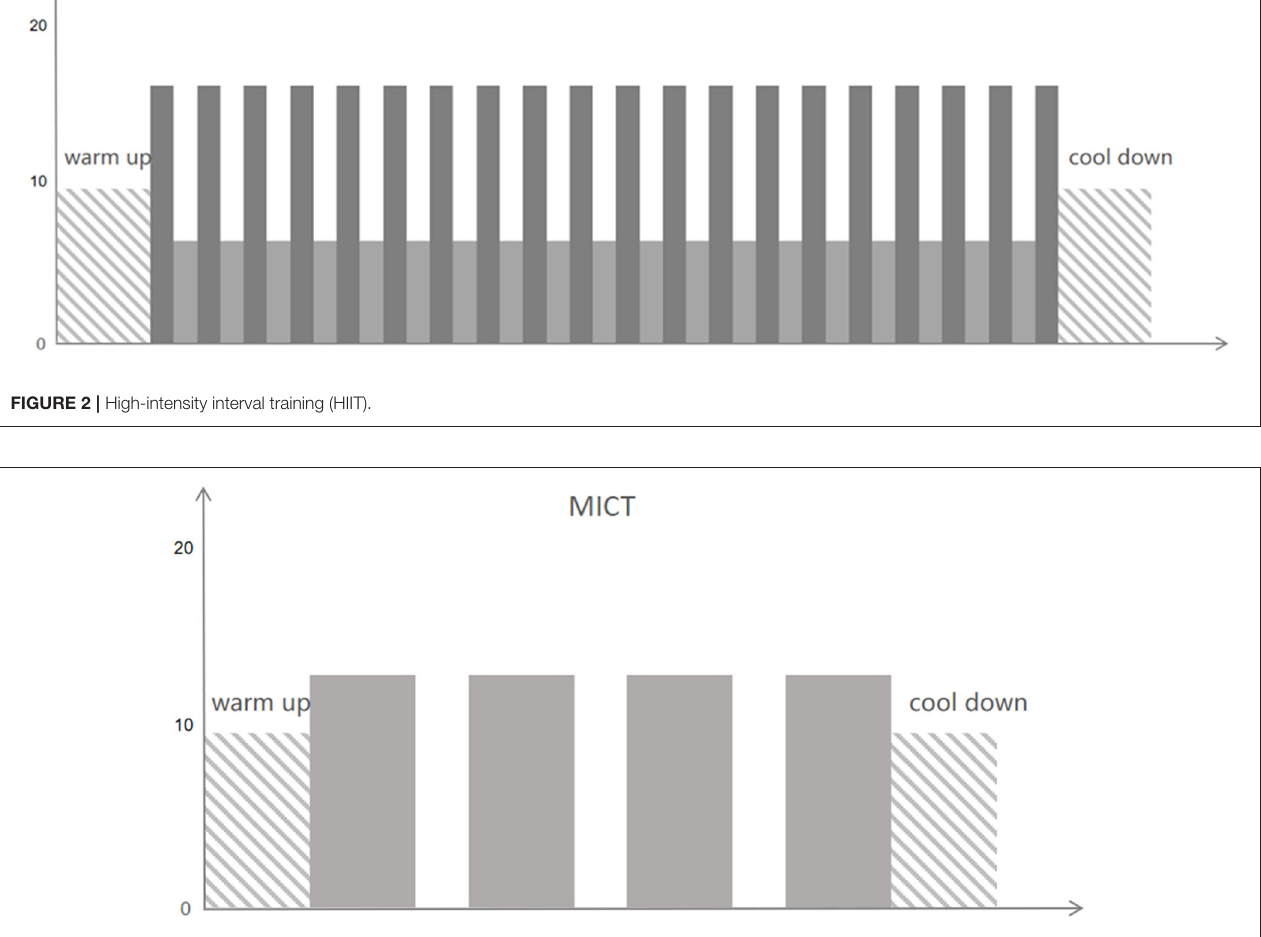
FIGURE 3 | Moderate-intensity continuous training